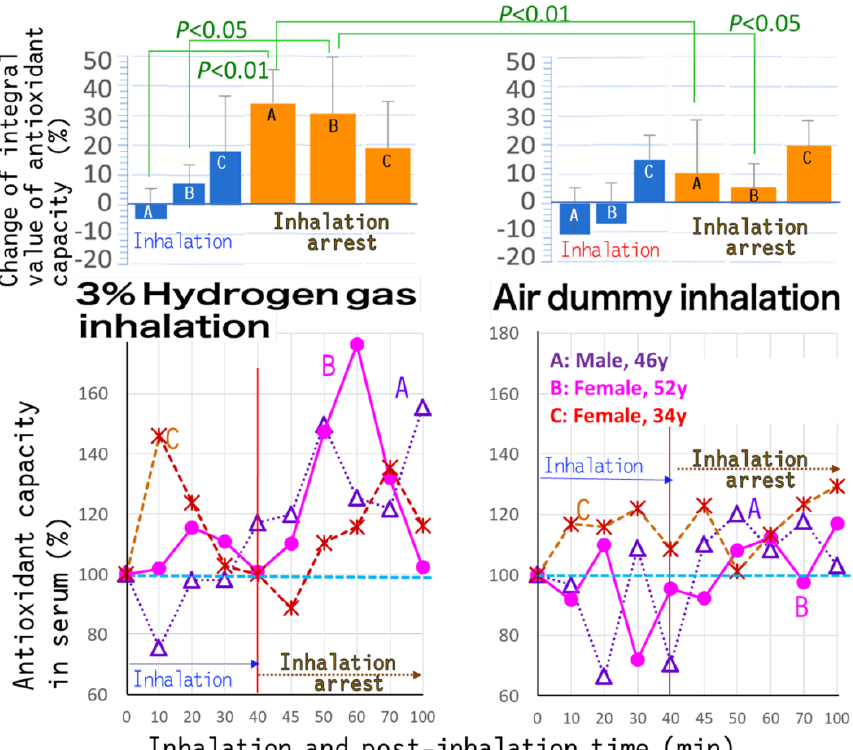
Figure 2. Antioxidant capacity in human serum, before/during/after inhalation of hydrogen gas or air. The hydrogen gas inhaler H2 inhaler LA was operated to generate hydrogen gas, and adjusted at a concentration of 3%. Three healthy subjects (a 46-year-old male, and 52- and 34-year-old females, respectively) inhaled for 40 min, and then the device was shut down. The antioxidant capacity in serum of the subjects during 40 min inhalation and for 60 min after termination of hydrogen gas inhalation was estimated for the oxygen radical absorption capacity (ORAC)-based antioxidant activity. The results were compared to those of air dummy inhalation which was conducted under the same conditions.